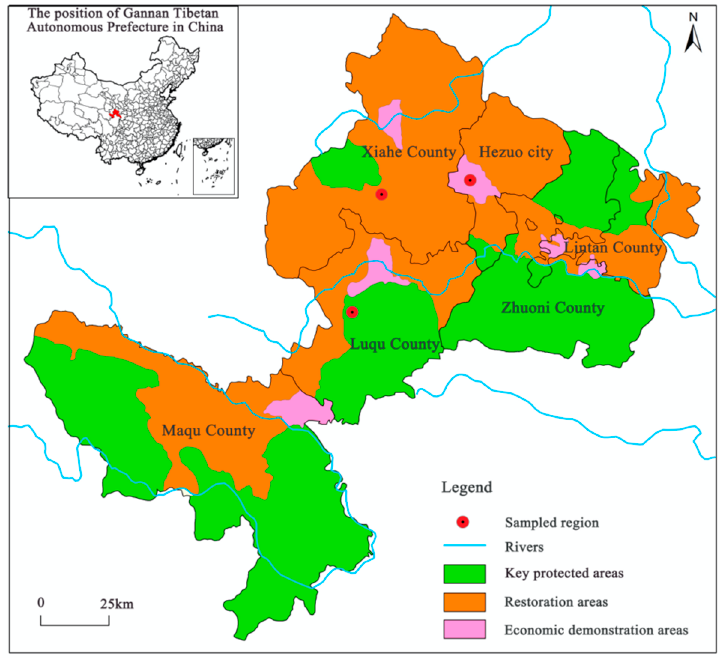
Figure 2. Study area. Table 4. Division of key ecological function zones of the Yellow River in